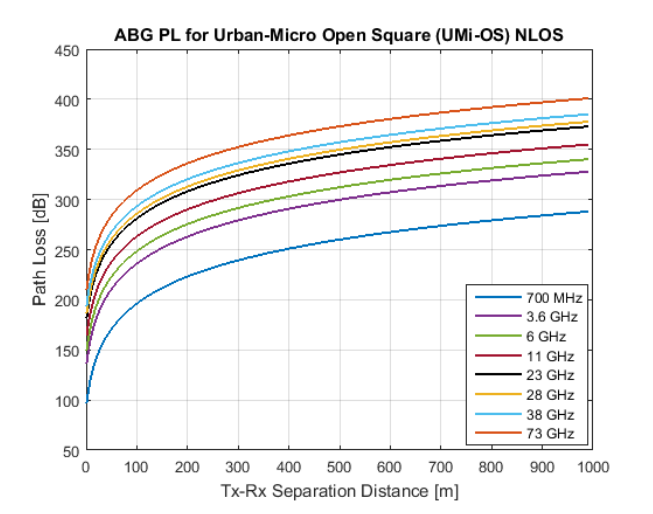
Fig 23. ABG UMi-OS (1000 m)